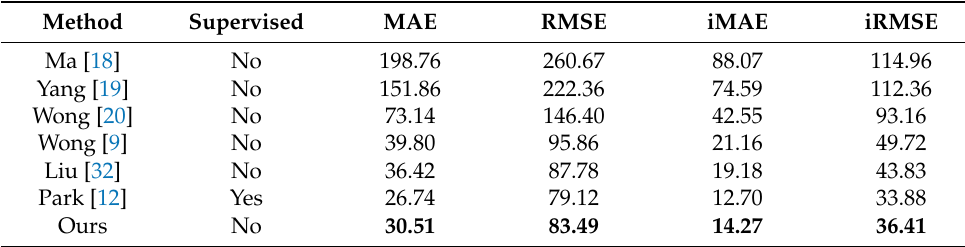
Table 4. Quantitative results of the VOID test dataset.